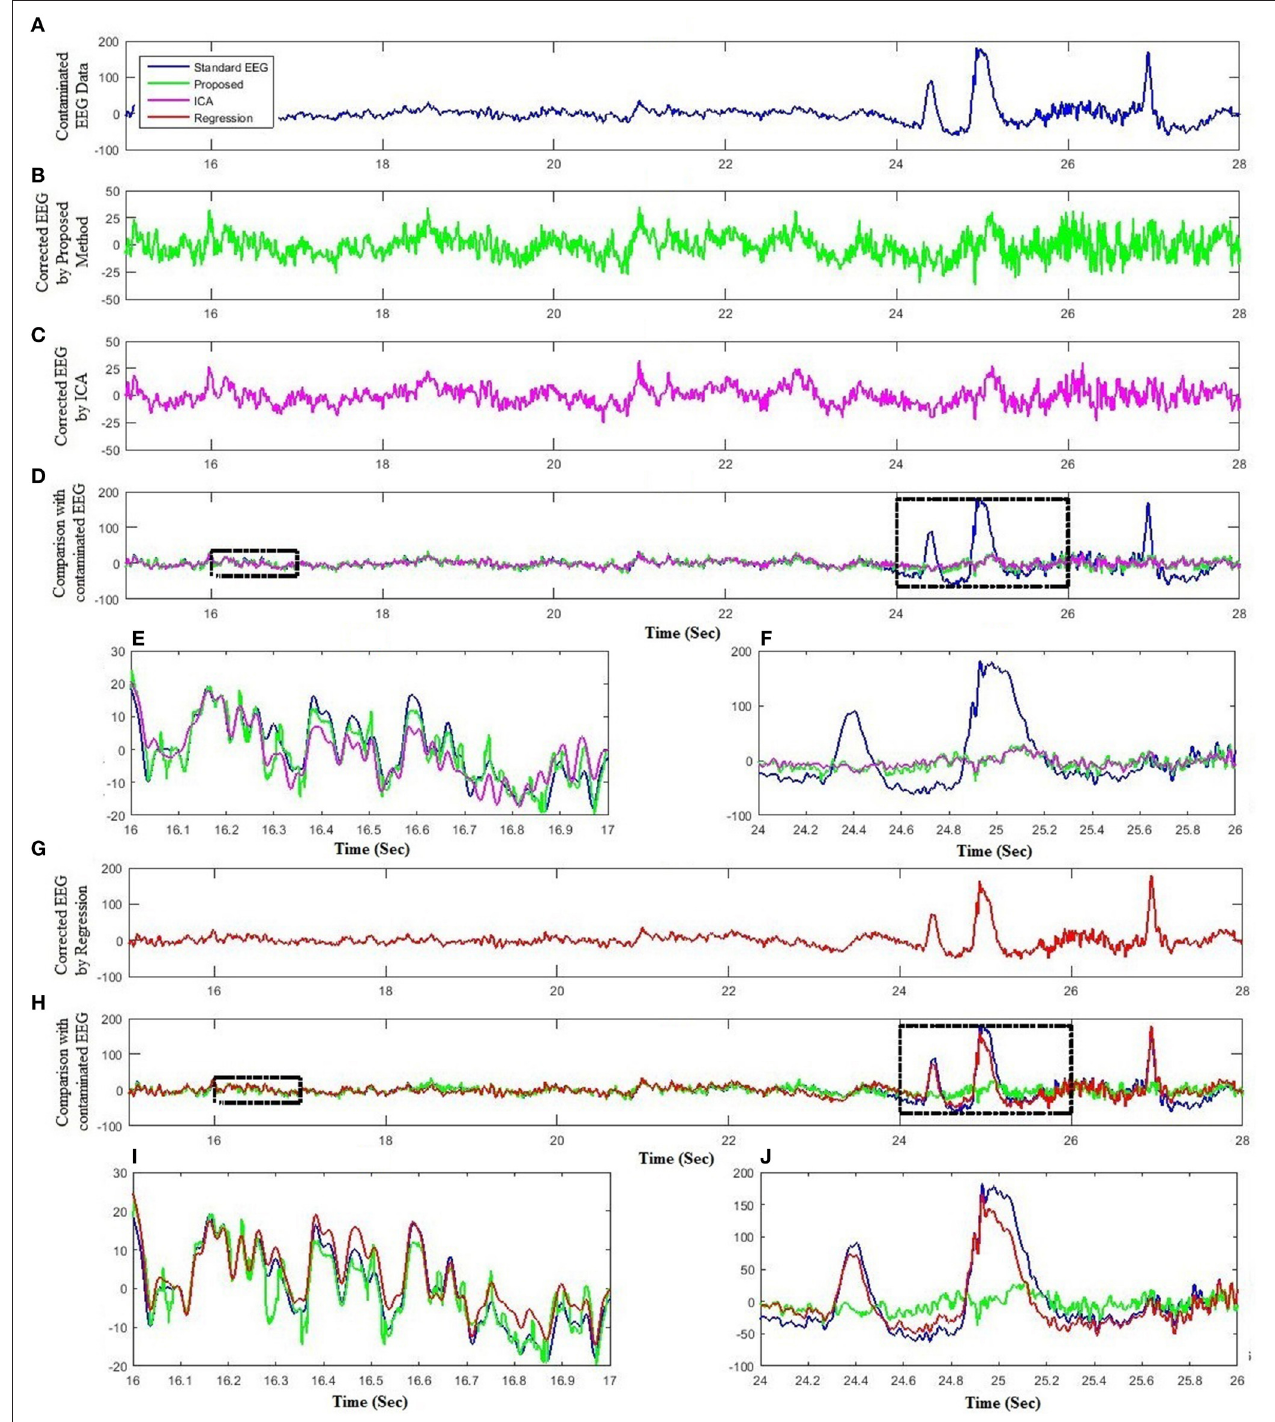
FIGURE 8 | Comparison of the proposed method with ICA and regression using standard dataset. (A) Standard EEG data. (B) Reconstructed EEG by the proposed method. (C) Reconstructed EEG by ICA. (D) Comparison of the proposed method and ICA reconstructed EEG with experimental EEG. (E) Partial enlargement of non-artifactual region. (F) Partial enlargement of artifactual region. (G) Reconstructed EEG by regression method. (H) Comparison of the proposed method and regression method reconstructed EEG with experimental EEG. (I) Partial enlargement of non-artifactual region. (J) Partial enlargement of artifactual region.